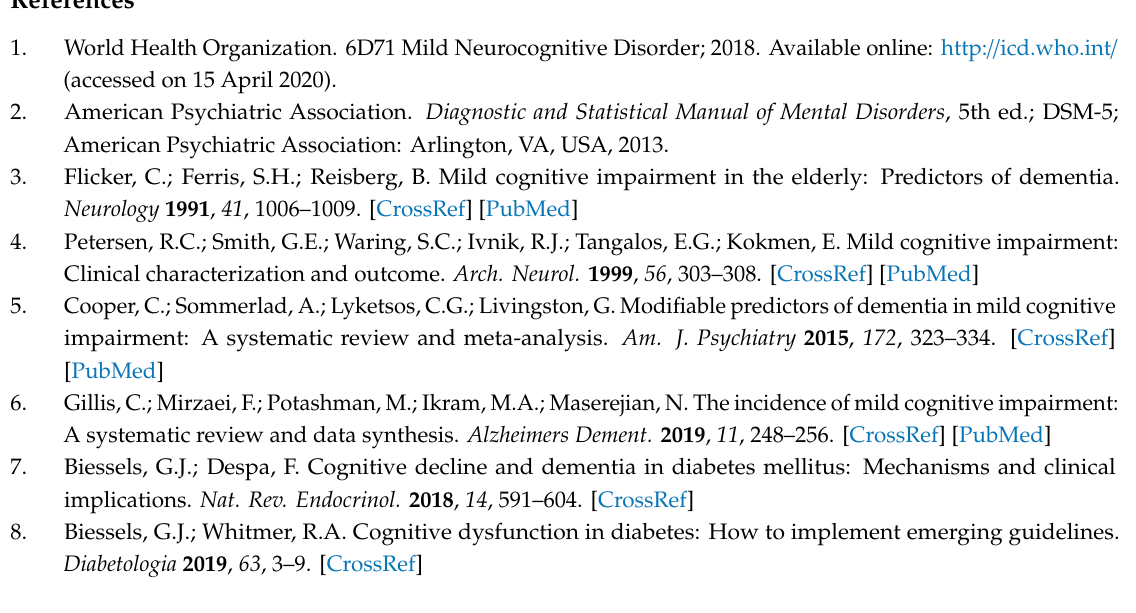
Figure S1: Enrollment flow chart, Figure S2: Baseline characteristics of subgroups of studied patients with type 2 diabetes